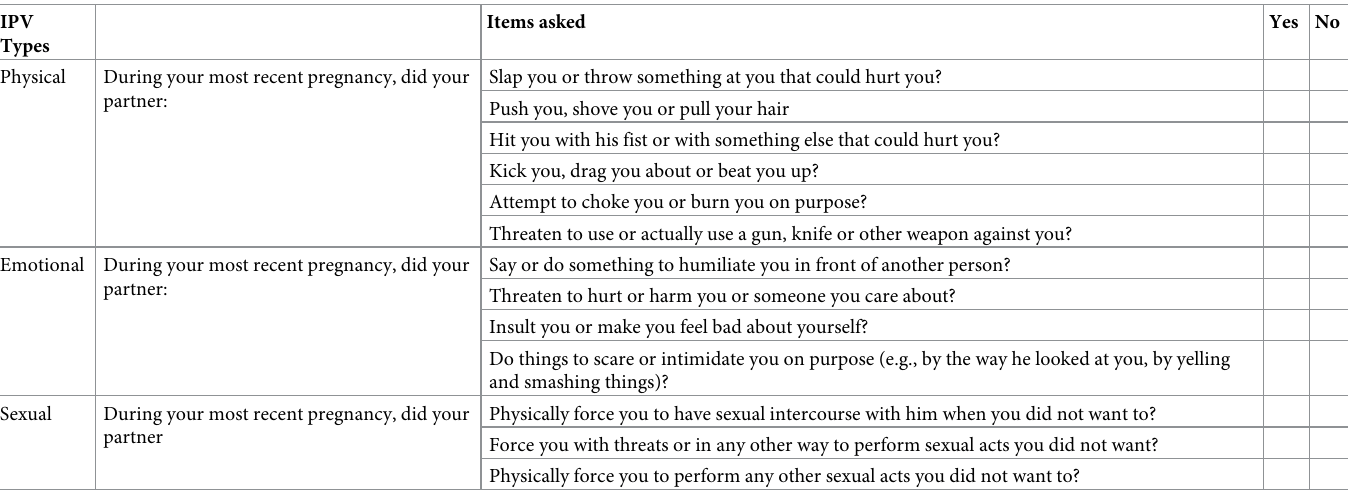
Table 1. Items used to measure different types of IPV in the current study. IPV